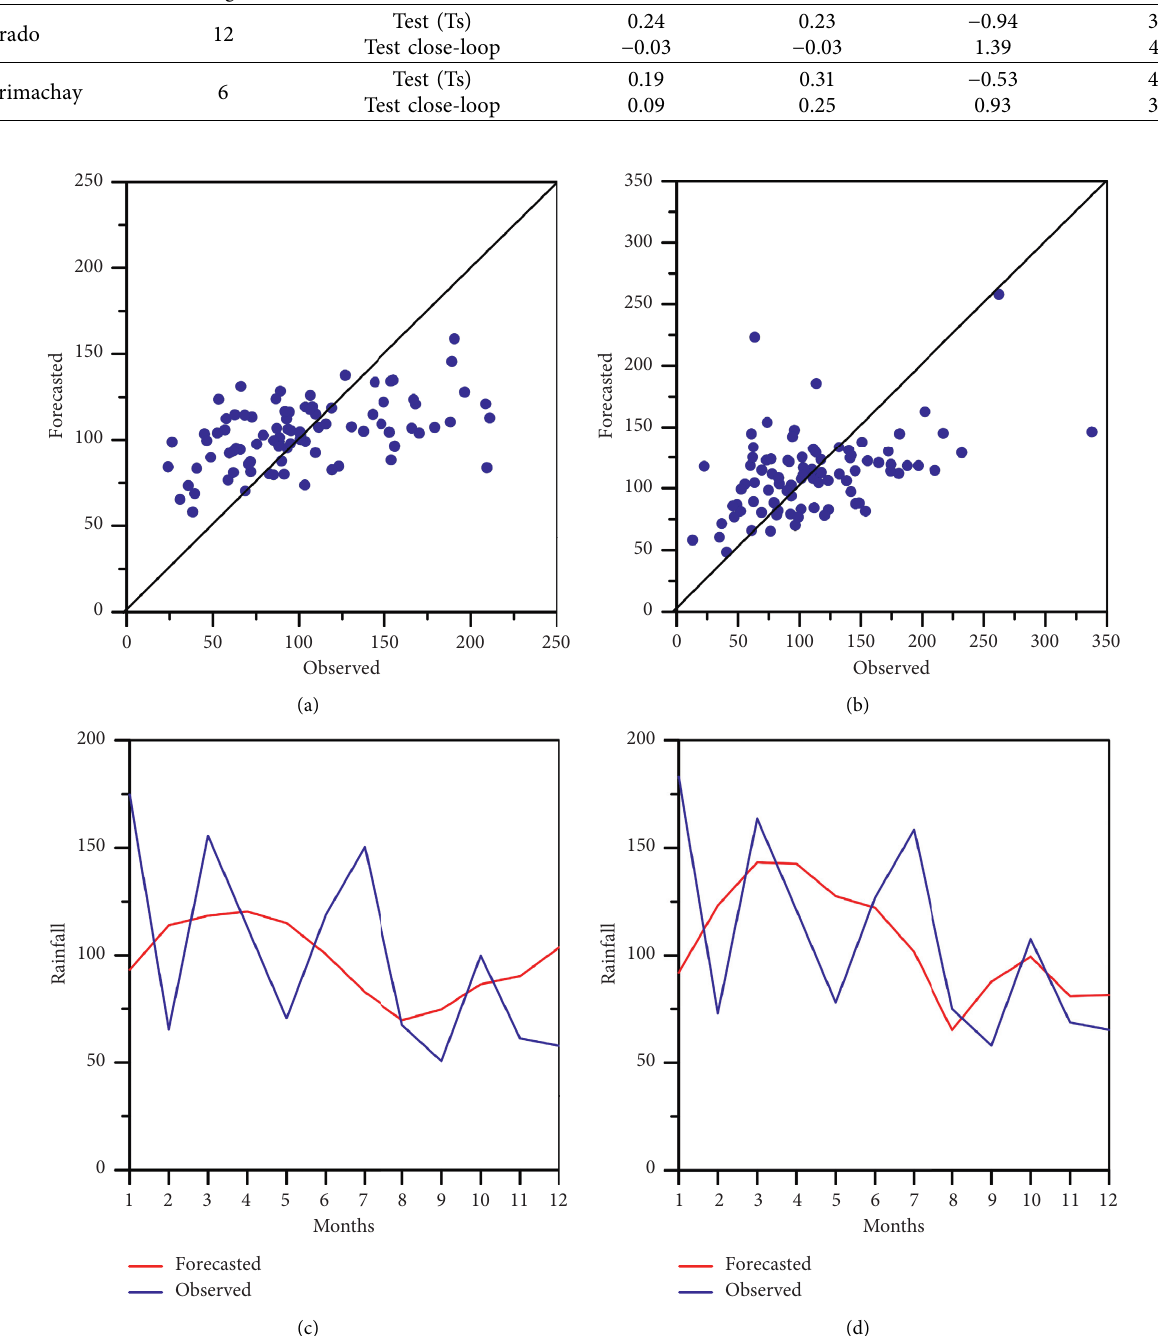
Figure 6: Comparison between predicted and observed values: (a) observed vs forecasted subset for Labrado; (b) observed vs forecasted Chirimachay; (c) forecasting for Labrado in 2015; (d) forecasting for Chirimachay in